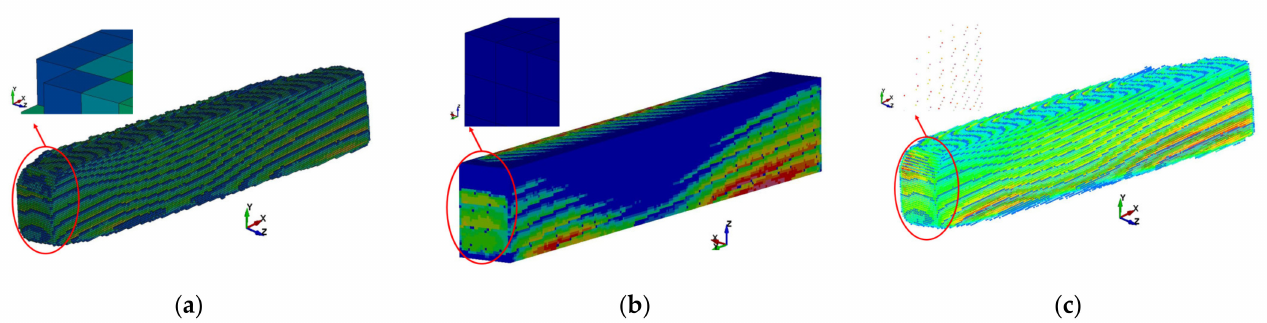
Figure 10. ( a ) Exemplary model of sample no. K2P3, made from tomography consisting of 187,664 voxels, ( b ) midpoints created from tomography, and ( c ) the model of the sample after remeshing 205,128 voxels. Table 6. Percentage distribution of voxels in the